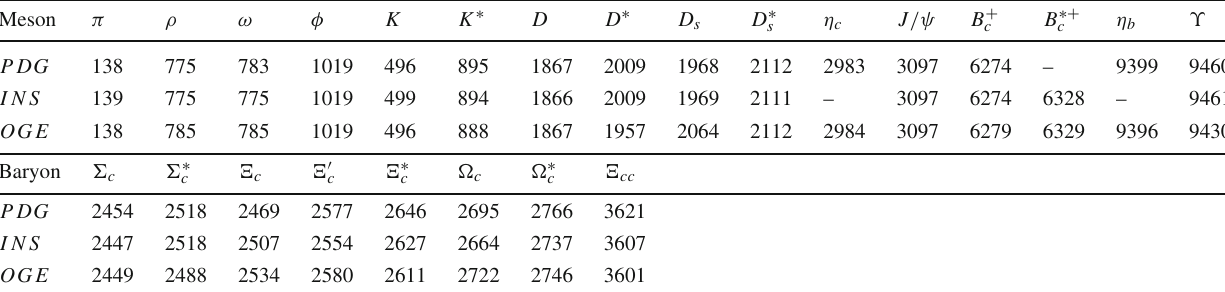
Table 3 Ground state hadron spectrum in the presently employed INS and OGE models compared to the experimental data, in unit of